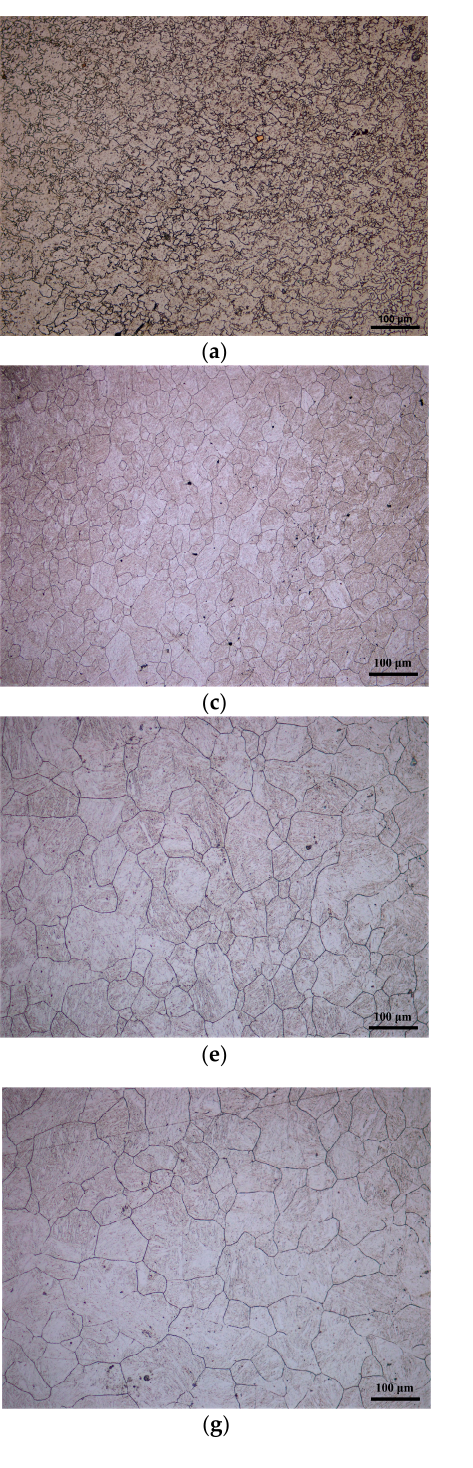
( b ) Figure 4. Microstructure of 20Mn5 steel compressed to a true strain of 0.7 under temperature of 1200 °C and strain rates of: ( a ) 1/s; ( b ) 0.1/s; ( c ) 0.01/s. 4. Establishment of A Two-Stage Constitutive Model and Its Verification 4.1. The Derivation of A Two-Stage Constitutive Model F Figure 5 shows two typical flow stress curves for hot working. In curve B, in the initial deformation stage (0 ≤ ε < ε c ), stress increases from σ 0 to σ c as a result of working hardening and dynamic recovery. When strain equals a critical value ε c , dynamic recrystallization occurs. And as strain increases, firstly, the stress increases from σ c to σ p , and then stress decreases form σ p to a steady state stress σ ss . If dynamic recrystallization never occurs in some materials, the change of stress with strain will be similar to curve A.